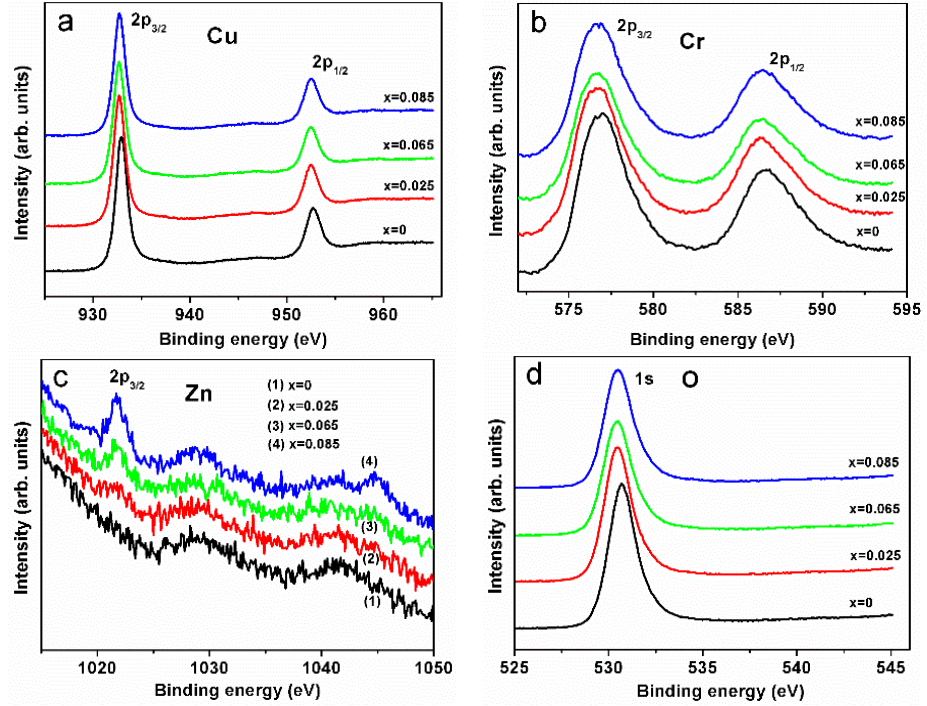
Figure 8. The photoelectron spectra of ( a ) Cu, ( b ) Cr, ( c ) Zn and ( d ) O of the CuCr 1 − x Zn x O 2 thin films ( x = 0, 0.025, 0.065, 0.085).